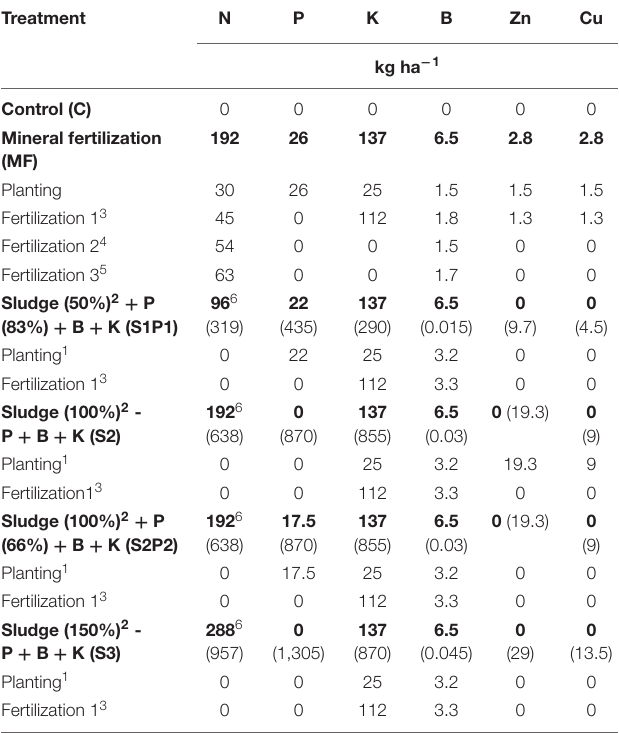
TABLE 3 | Amount of nutrients applied by treatments with mineral fertilizers and sewage sludge.